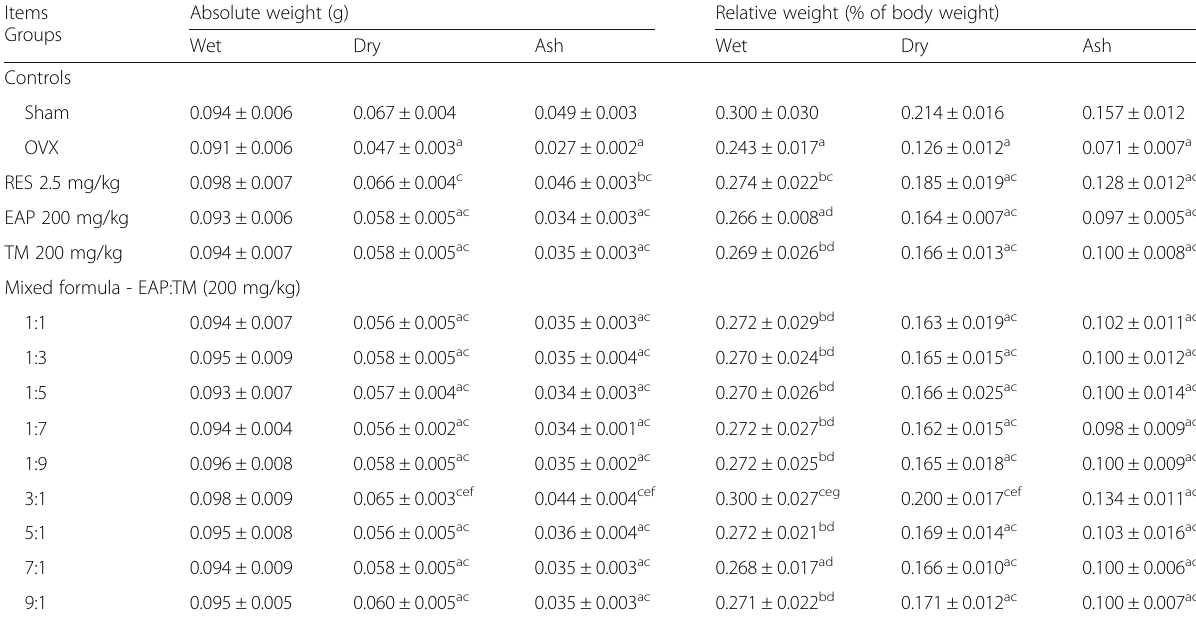
Table 2 Right femur weights of sham-operated and OVX